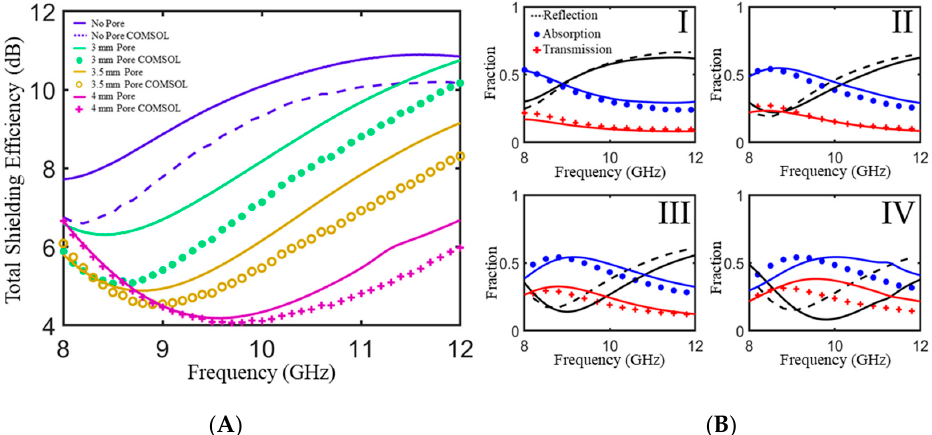
Figure 6. ( A ) Measured and simulated total shielding efficiency in an X-band waveguide for a 5% M25/PLA composite plaque with and without pores of varying height. ( B ) Measured and simulated power balance for a 5% M25/PLA composite plaque (I) without pores, (II) a cylindrical pore with a height of 3 mm, (III) a cylindrical pore with a height of 3.5 mm, and (IV) a cylindrical pore with a height of 4 mm. All plaques have a total thickness of 4.6 mm. All cylindrical pores have a diameter of 2.54 mm. Simulated data is depicted with symbols and experimental data is represented by solid lines of the same color.